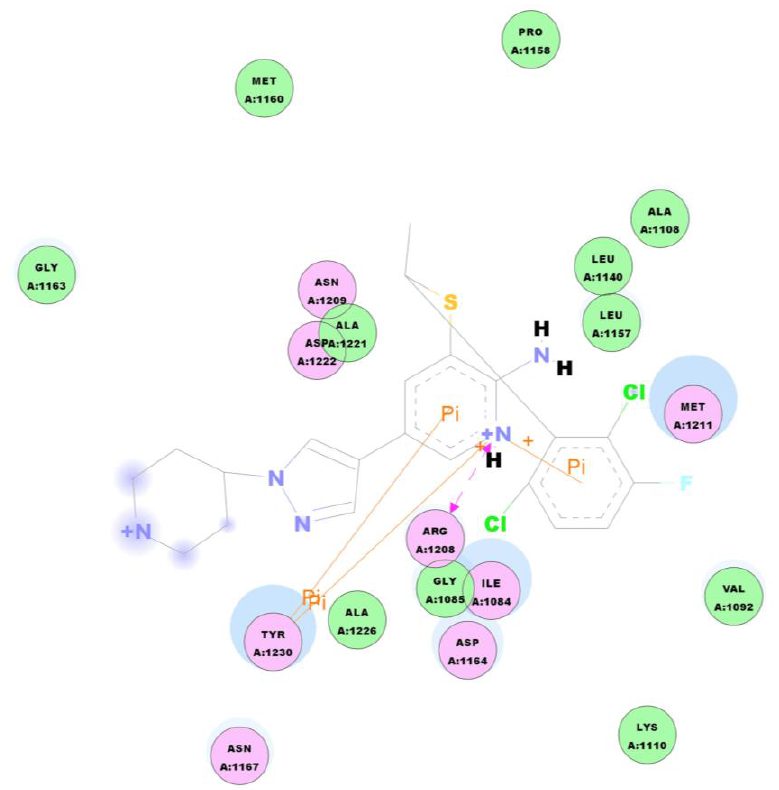
Figure 6. 2D diagram of docking interaction of compound 4 with c-Met Kinase 3CCN.